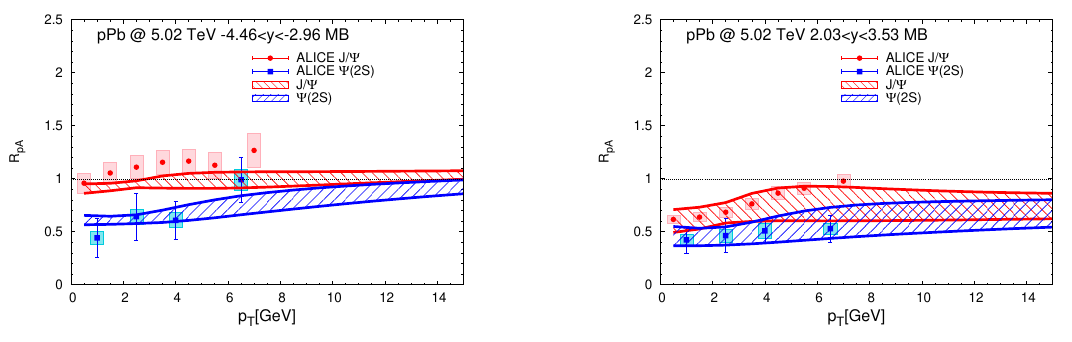
Figure 6 . Nuclear modi(cid:12)cation factor as a function of transverse momentum for J= (red bands) and (2 S ) (blue bands) in MB 5.02 TeV p -Pb collisions, compared to ALICE data [18, 19]. The left (right) panel is for backward (forward) rapidity. The uncertainty bands include variations in CNM and charmonium formation time